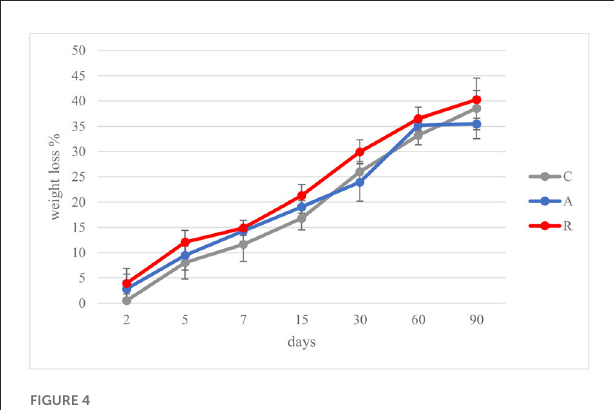
FIGURE4 Weight loss (%) during ripening of: non-inoculated sausages, C; sausages inoculated with Lcb. casei N87 cultivated under anaerobiosis, A; sausages inoculated with Lcb. casei N87 cultivated under respiratory conditions, R. Error bars refer to the standard deviations obtained from triplicate sample